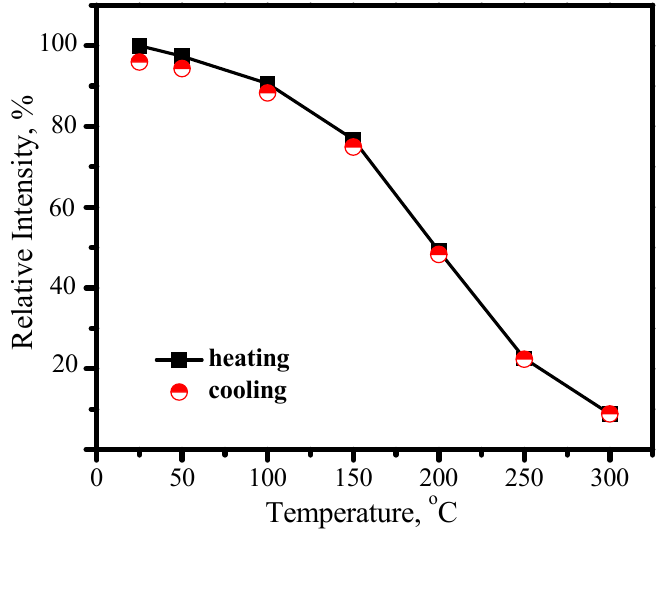
Sr Eu )SiO as a function of temperature. 1.1 0.7 0.2 4